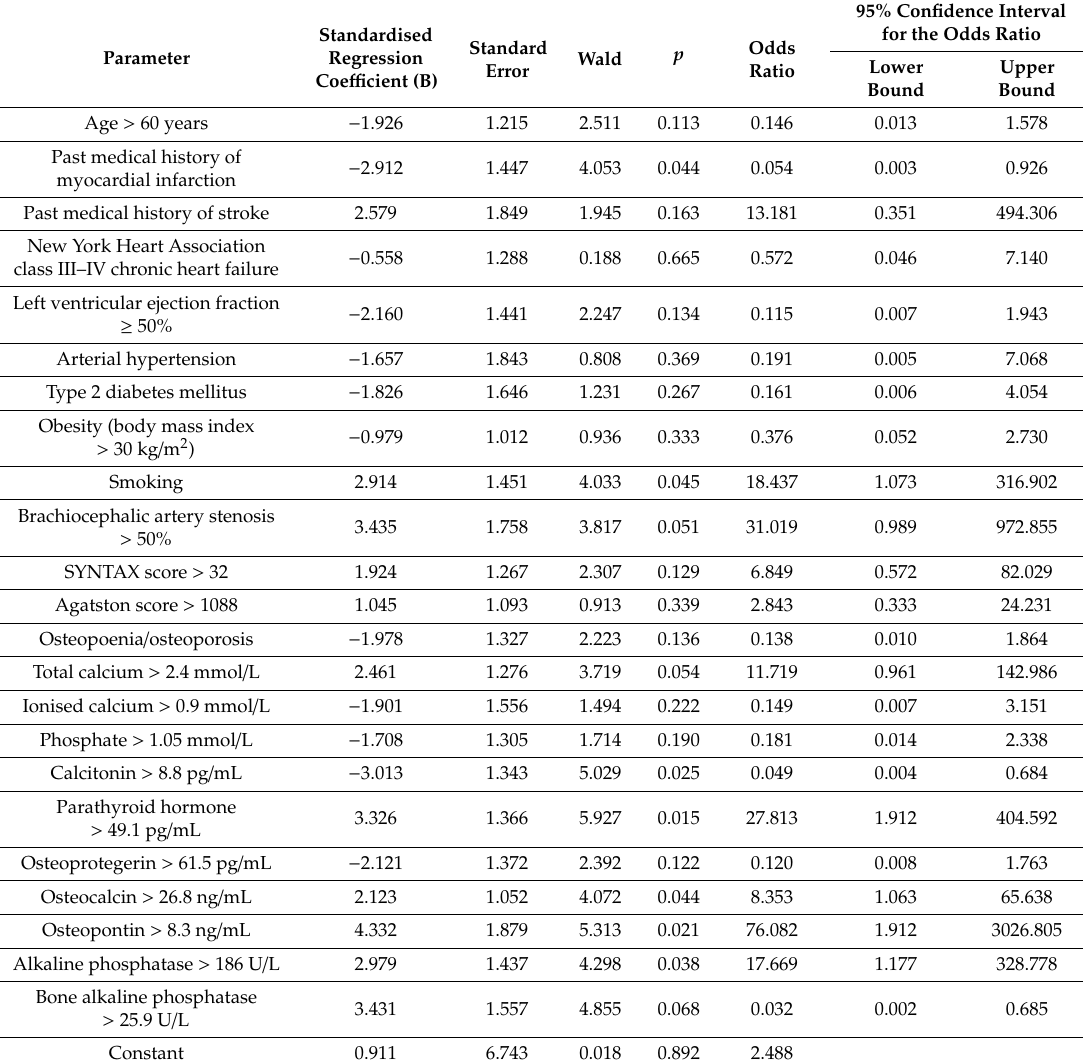
Table 7. Variables included into enter logistic regression equations to predict an adverse cardiovascular